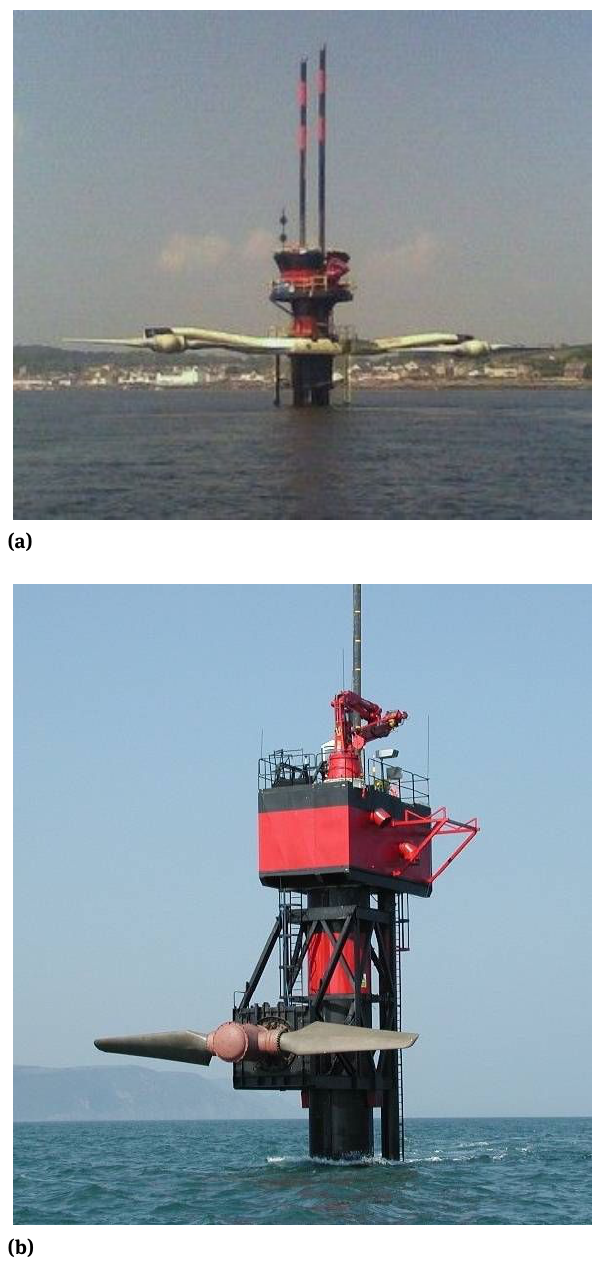
Figure 3: a) Two rotors SeaGen turbine, with the rotors raised for maintenance. Image from [30]. By Fundy - Own work. CC BY-SA 3.0. b) Single rotor SeaFlow turbine, with the rotor raised for mainte- nance. Image from [31]. By Fundy - Own work. CC BY-SA 3.0